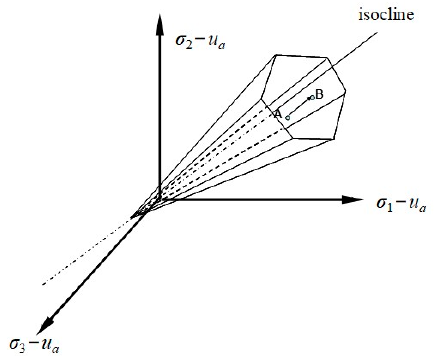
Figure 3. Strength surface in 3-D effective stress.